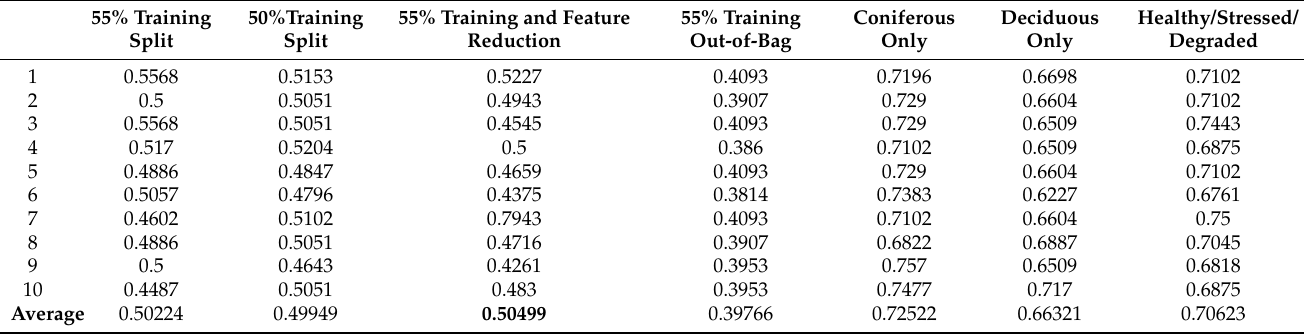
Table 2. NAIP imagery classification accuracies for each random forest classification method. The highest accuracy for our five-class scheme is shown in bold.